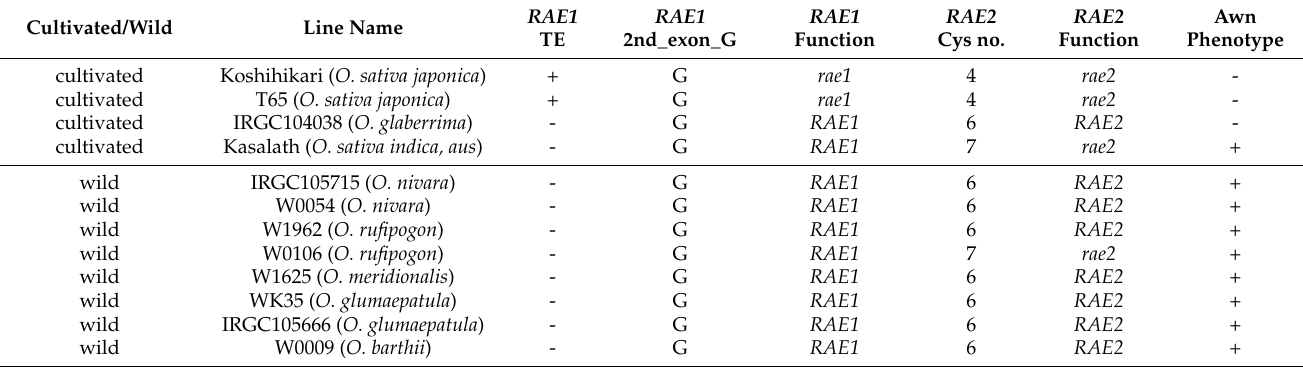
Table 2. Sequence comparison of RAE1 and RAE2 in recurrent and donor